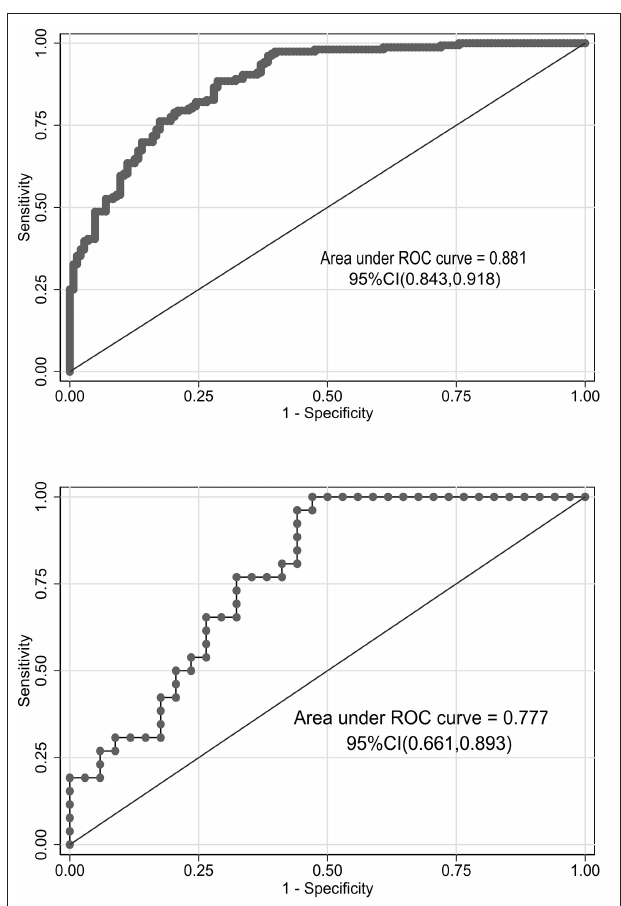
FIGURE 3 | Receiver operating characteristic (ROC) curves of the nomograms in training and validation cohorts. The area under the ROC curve in the training cohorts and the validation cohorts was 0.881 (95% CI: 0.843–0.918) and 0.777 (95% CI: 0.661–0.893),